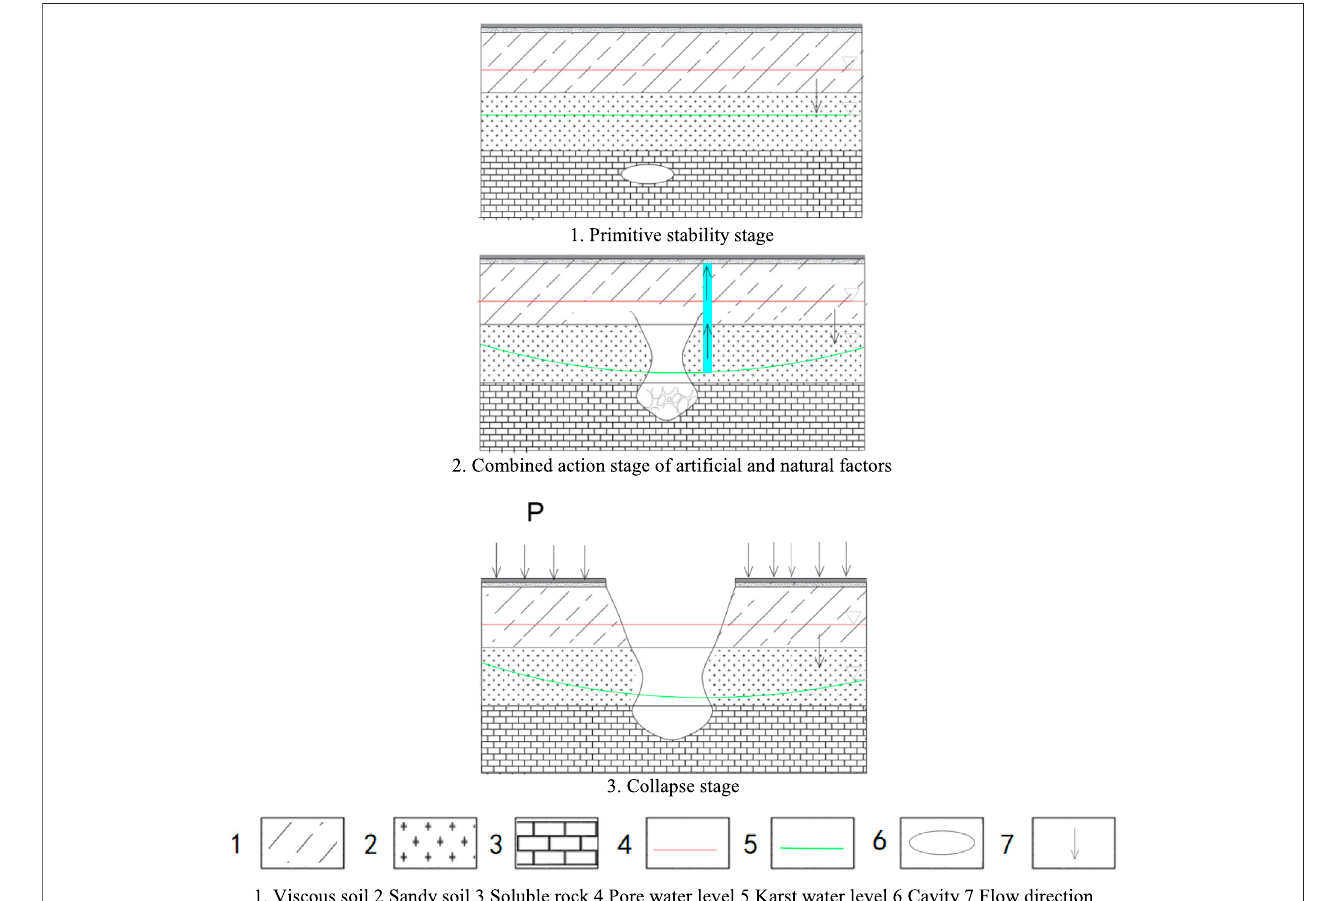
FIGURE 8 | Schematic of the evolution process of karst collapse in Fenghuo Village. 1. Primitive stability stage, 2. Combined action stage of arti fi cial and natural factors, 3. Collapse stage. 1. Viscous soil 2 Sandy soil 3 Soluble rock 4 Pore water level 5 Karst water level 6 Cavity 7 Flow direction.